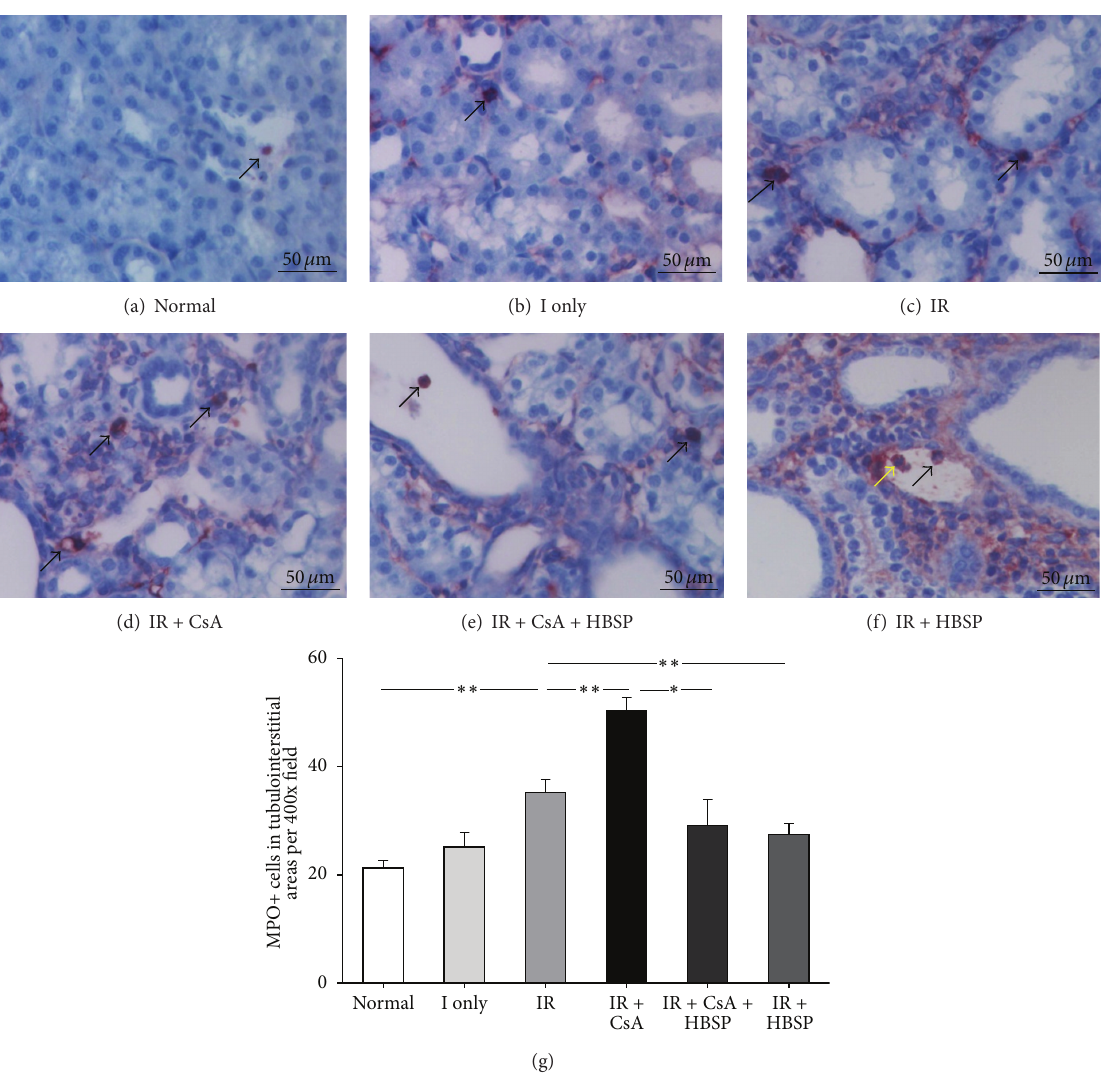
Figure 5: Myeloperoxidase (MPO)+ cells (dark red color), detected by Immunostaining, were mainly located in tubular lumens (e, f) and interstitial areas (b–e); and a few were also seen in tubular areas (a, c) and glomerular areas. MPO+ cells were significantly increased by IR and CsA but decreased by HBSP (g). The yellow arrow indicated a MPO+ cell with apoptotic feature (f). Data are expressed as mean number in the high power field of each group (mean ± SEM; 𝑛 = 6 ). ∗ 𝑃 < 0.05 ; ∗∗ 𝑃 < 0.01